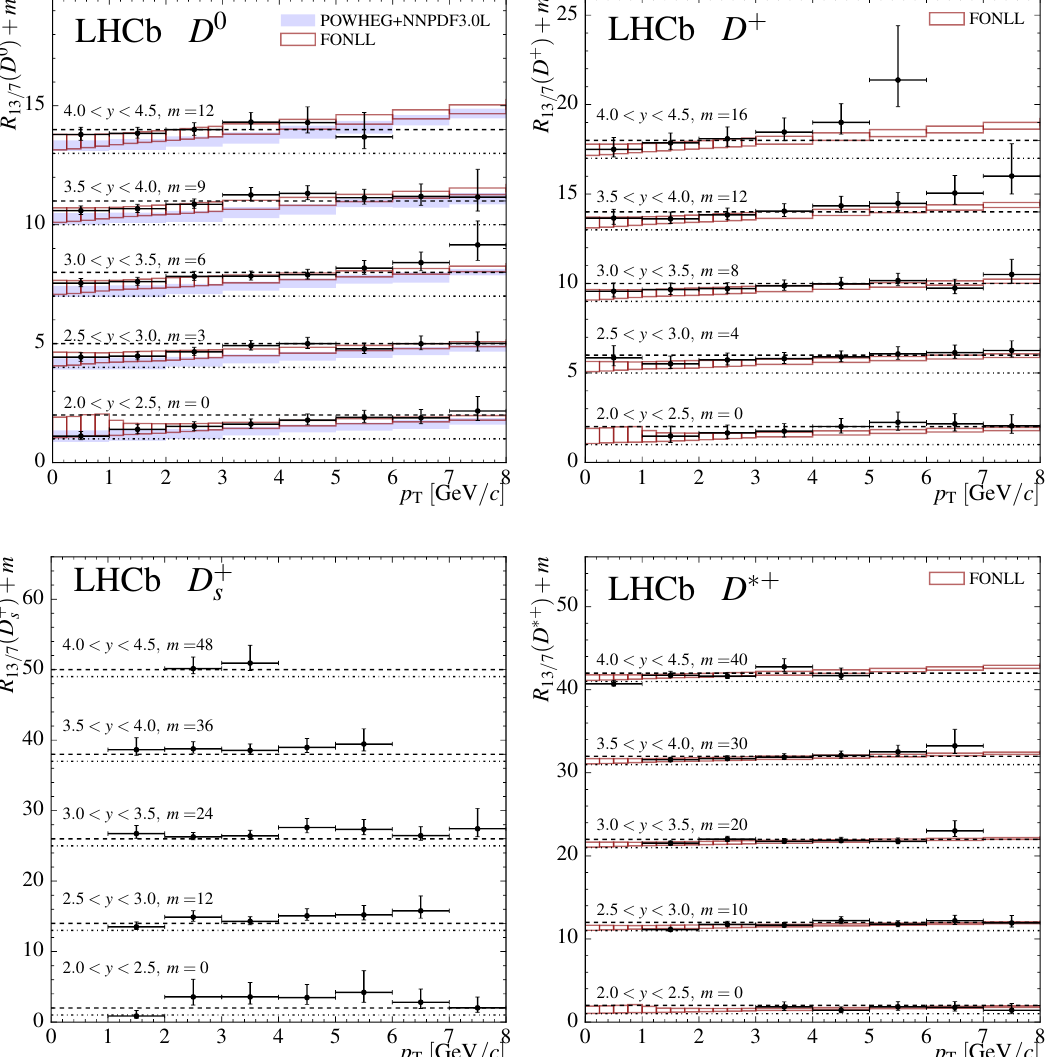
Figure 7. Measurements and predictions of the prompt D 0 , D + , D + The dash-dotted lines indicate the unit ratio for each of the rapidity intervals and the dashed lines indicate a ratio of two. Each set of measurements and predictions in a given rapidity bin is o(cid:11)set by an additive constant m , which is shown on the plot. No prediction is available for the D +